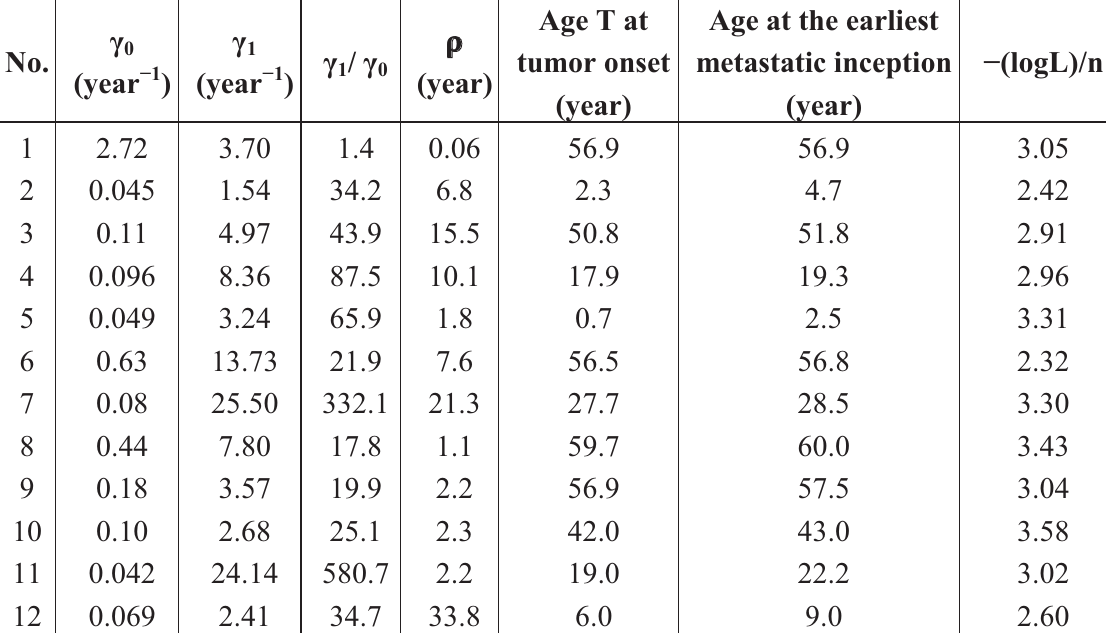
Table 4. Biological parameters of the Homogeneous model ( (cid:581)(cid:3)(cid:3404)(cid:3)(cid:882) ).